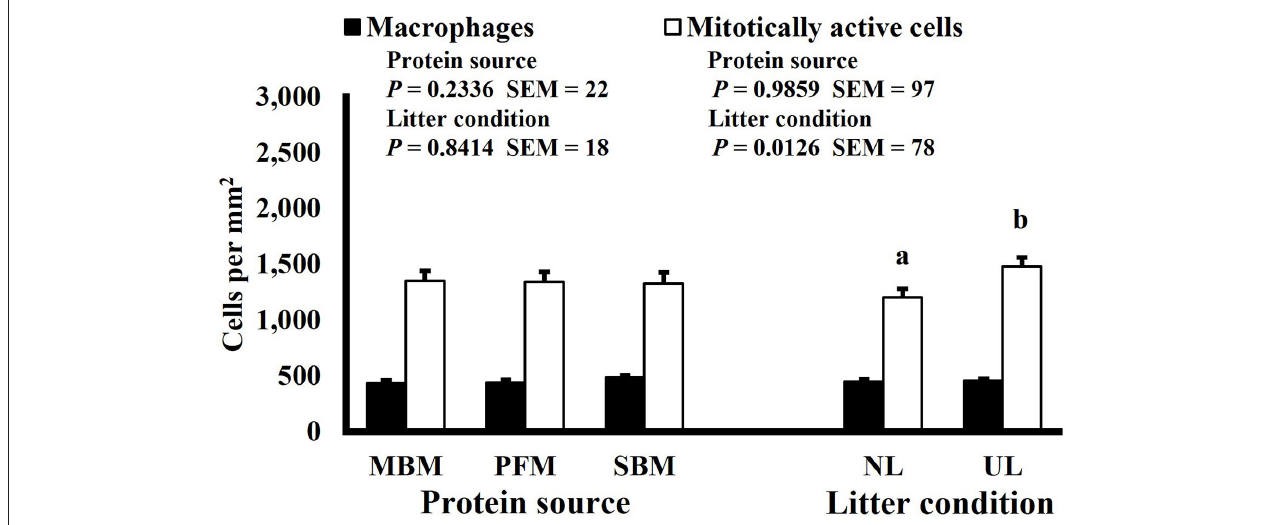
FIGURE 2 | Effect of dietary protein source and litter condition on macrophage (KUL01 + ) and mitotically active (BrdU + ) cell densities (cells per mm 2 ) in the duodenum of 15-d-old broilers ( n = 36 per sampling d, 6 birds per treatment). MBM, meat and bone meal; PFM, 50% poultry by-product and 50% feather meal blend; SBM, soybean meal; NL, new litter; UL, used litter. a,b Bars of the same color representing means from either dietary protein source or litter condition with different superscripts differ at P ≤ 0.05.